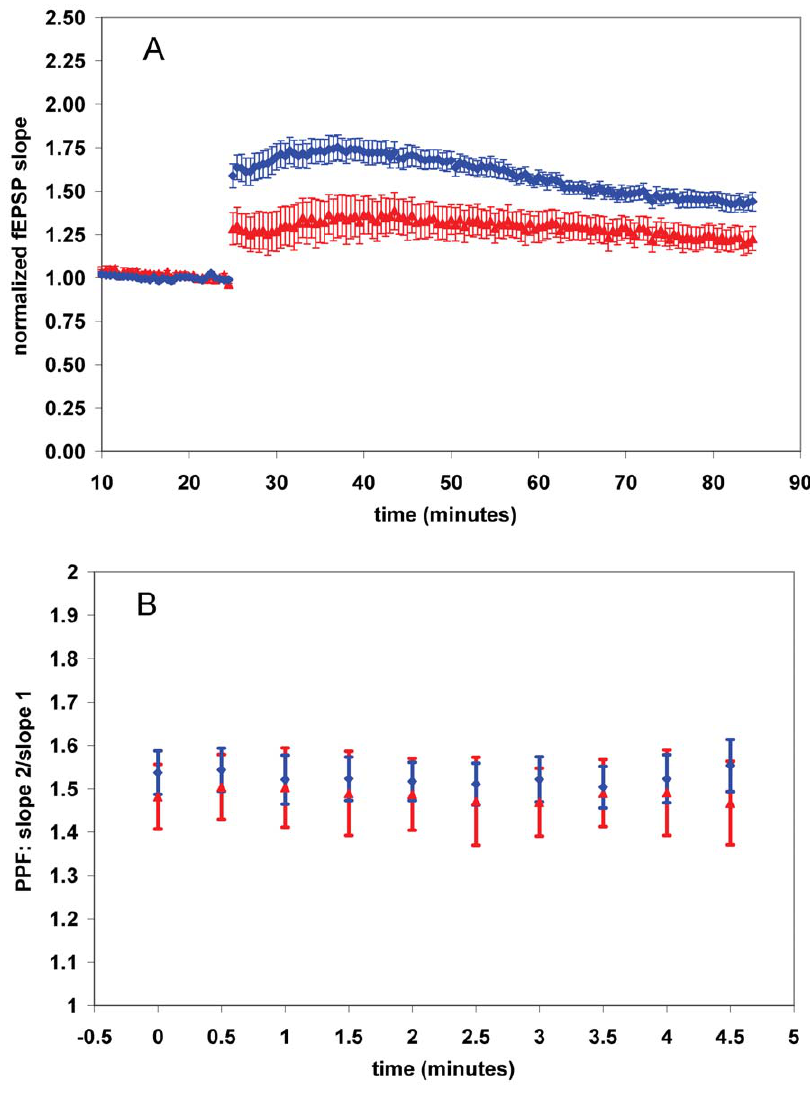
Figure 7. Invivo METH exposure also decreases LTP. ( A ) Summary plot of normalized fEPSP slope measurements recorded in the CA1 region of the hippocampus. The red triangles are from METH-treated mice; the blue diamonds show results from vehicle-treated subjects. Error bars are 6 SEM. ( B ) Summary plot of paired-pulse facilitation measurements recorded in the CA1 region of the hippocampus. The red triangles are from METH-treated mice; the blue diamonds show results from vehicle-treated subjects. Error bars are 6 SEM.